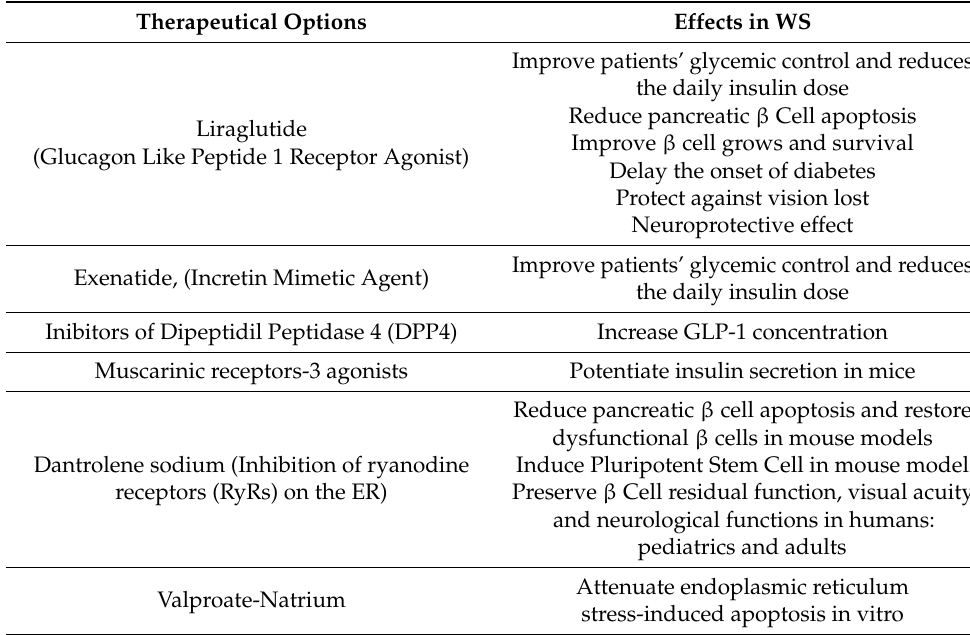
Table 2. New therapeutic strategies in Wolfram